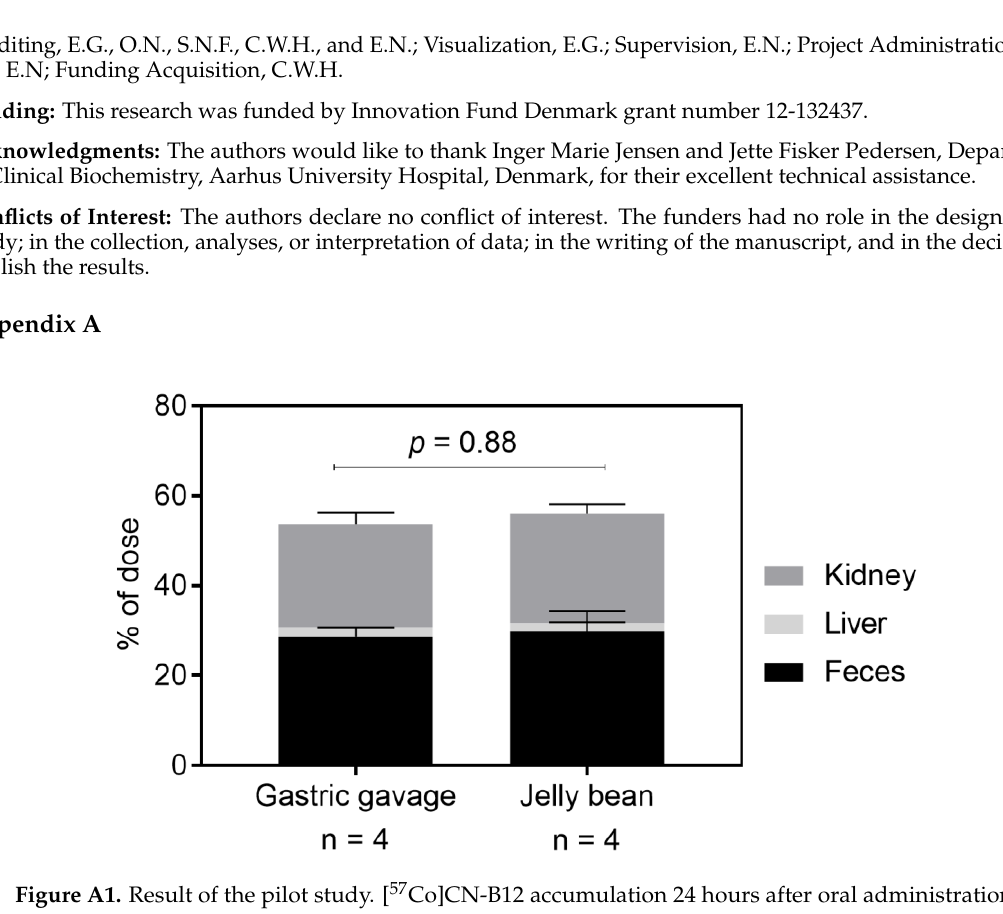
Figure A1. Result of the pilot study. [ 57 Co]CN-B12 accumulation 24 hours after oral administration. Kidney, liver, and feces were collected from two groups of rats ( n = 4 in each group) kept for two weeks on a low-B12 diet before given a single oral dose of radiolabeled [ 57 Co]CN-B12 by either gastric gavage or in a jelly bean. Results are given as the percentage of cpm of the given dose of [ 57 Co]CN-B12. Stacked mean values with SEM are shown. No differences were observed in kidneys ( p = 0.69), liver ( p = 0.34), or feces ( p = 0.69) between the two groups, or in the sum of cpm measured ( p = 0.88). The Mann Whitney test was used to compare the two groups, and p -values ≤ 0.05 were considered statistical